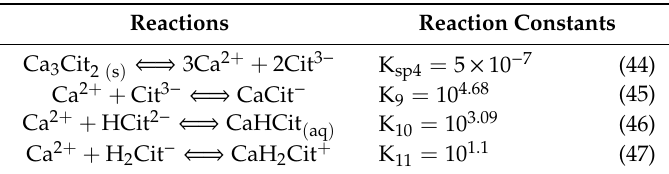
Table 7. Reactions and corresponding reaction constants.